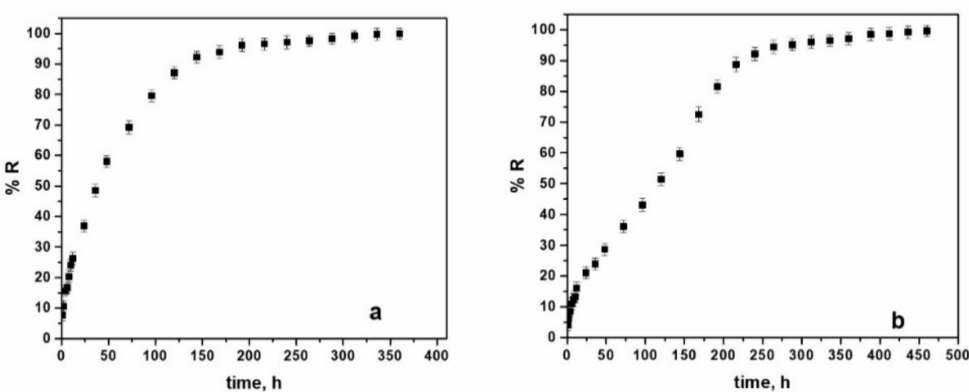
Figure 11. Indomethacin release profiles from the PPy-Indo coatings electrosynthesized on WBC alloy ( a ) and Hera type alloy ( b ) from an ionic-liquid electrolyte containing 0.5 M Py and 0.025 M